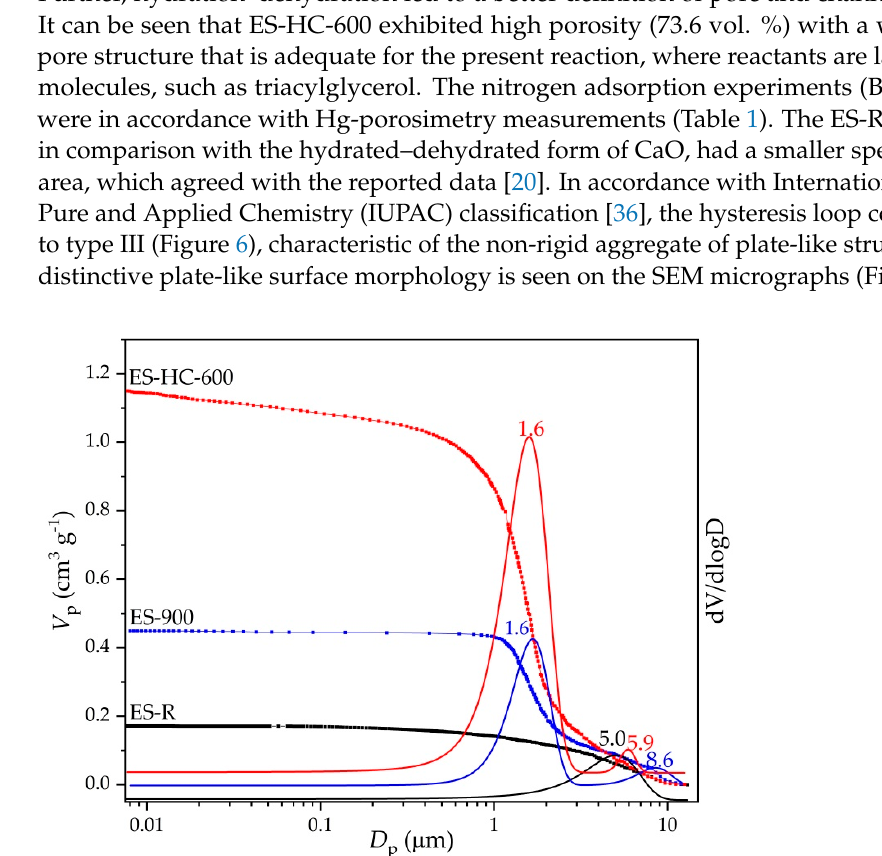
Figure 3. FT-IR spectra of ES-R, ES-H, and ES-HC-600.